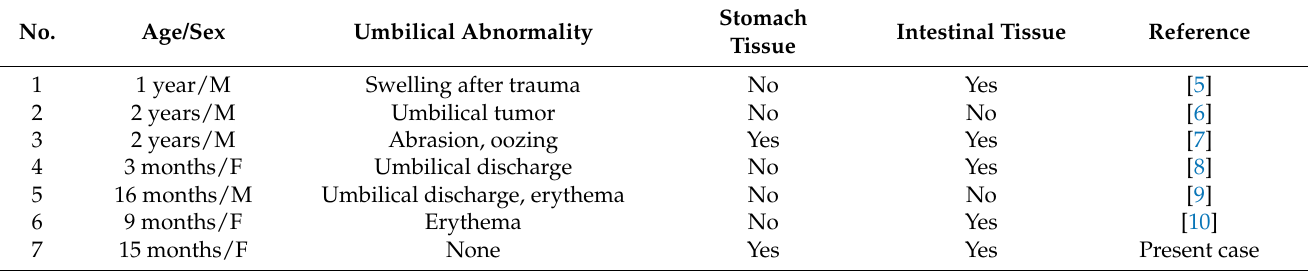
Table 1. Summary of cases of omphalomesenteric cyst with the ectopic pancreatic tissue. Age at operation, sex, umbilical symptom, and the presence of stomach and intestinal tissues in pathological diagnosis were compared between the present case and previous